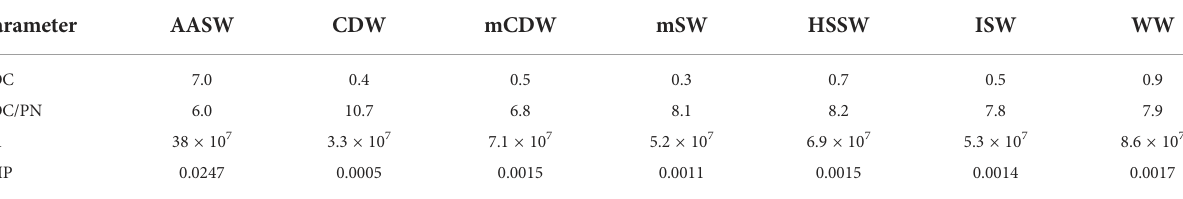
TABLE 2 Average concentrations of particulate organic carbon (POC; m mol kg − 1 ), molar ratio between particulate organic carbon and particulate nitrogen (POC/PN), prokaryotic abundance (PA; cell L − 1 ), prokaryotic heterotrophic production (PHP; µgC L − 1 h − 1 ) for each water mass in the Ross